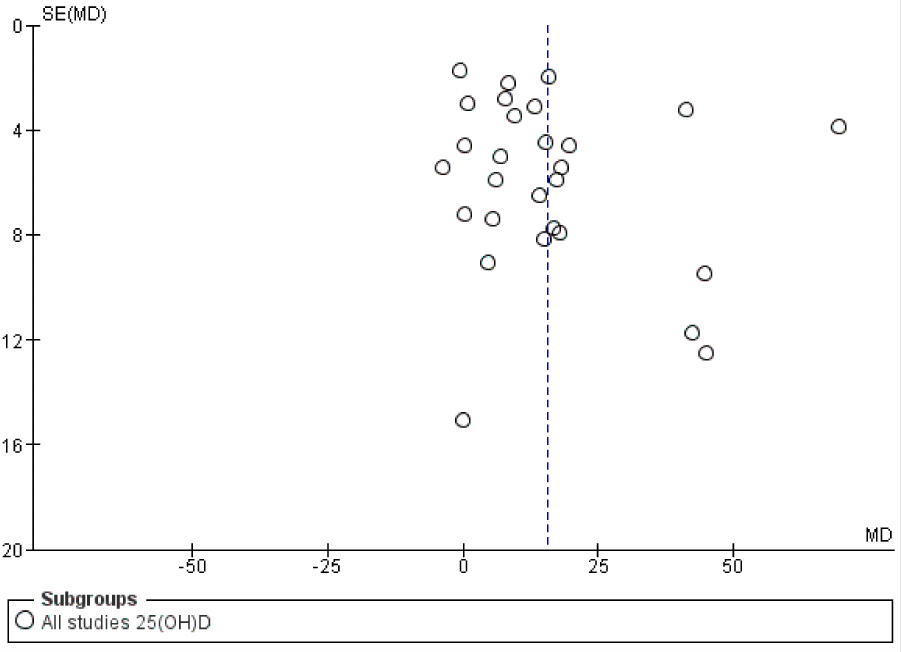
Figure 4. Funnel plot for total 25(OH)D. Legend: Funnel plot with X axis representing the estimated measure (standardized mean difference) of the 25(OH)D and Y axis representing the precision of the measure (standard error). The funnel plot suggests relatively mixed quality studies (due to variations in the standard